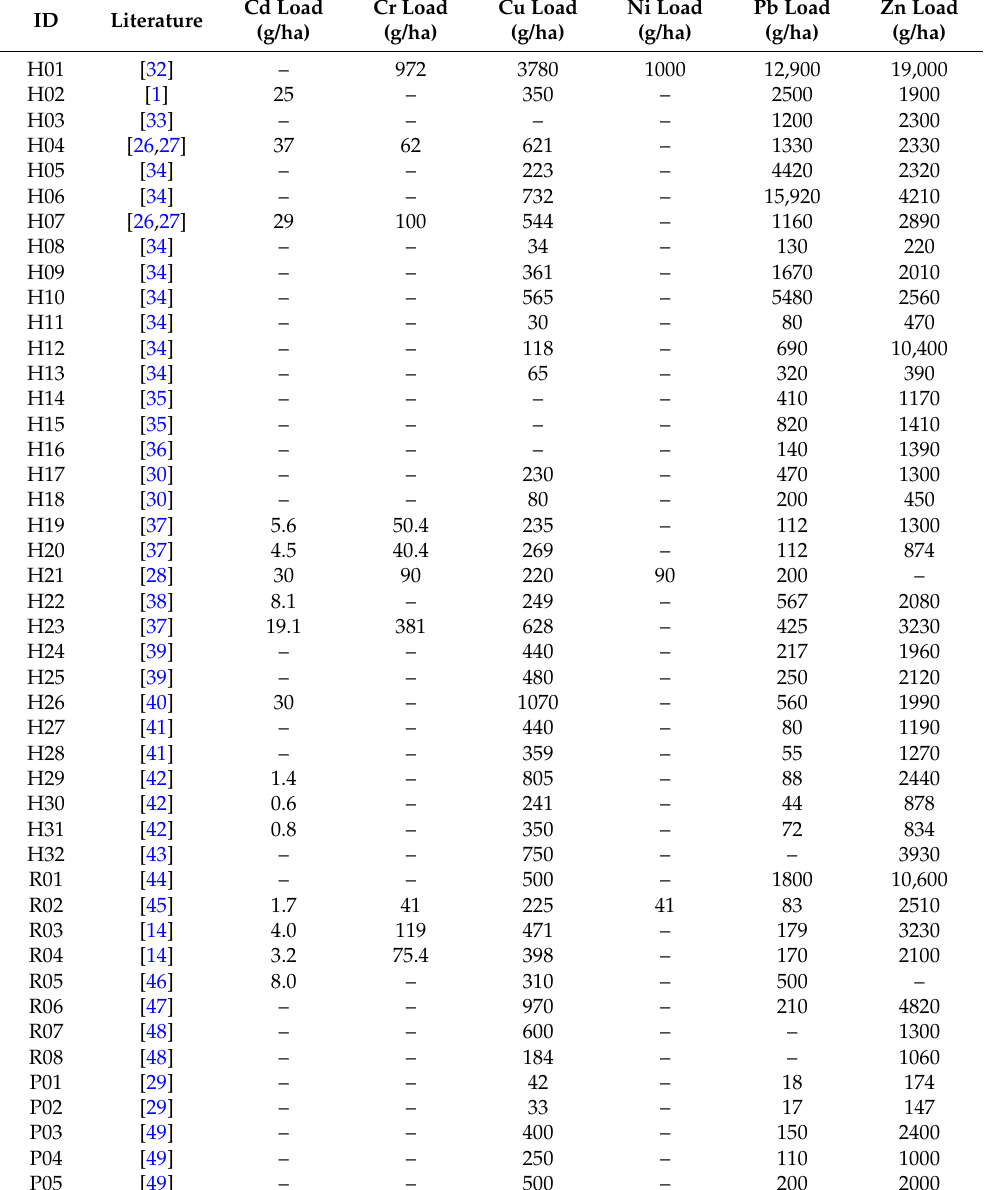
Table 2. Annual total heavy metal loads in runoff from traffic areas. The characteristics of all traffic area sites are described in Table